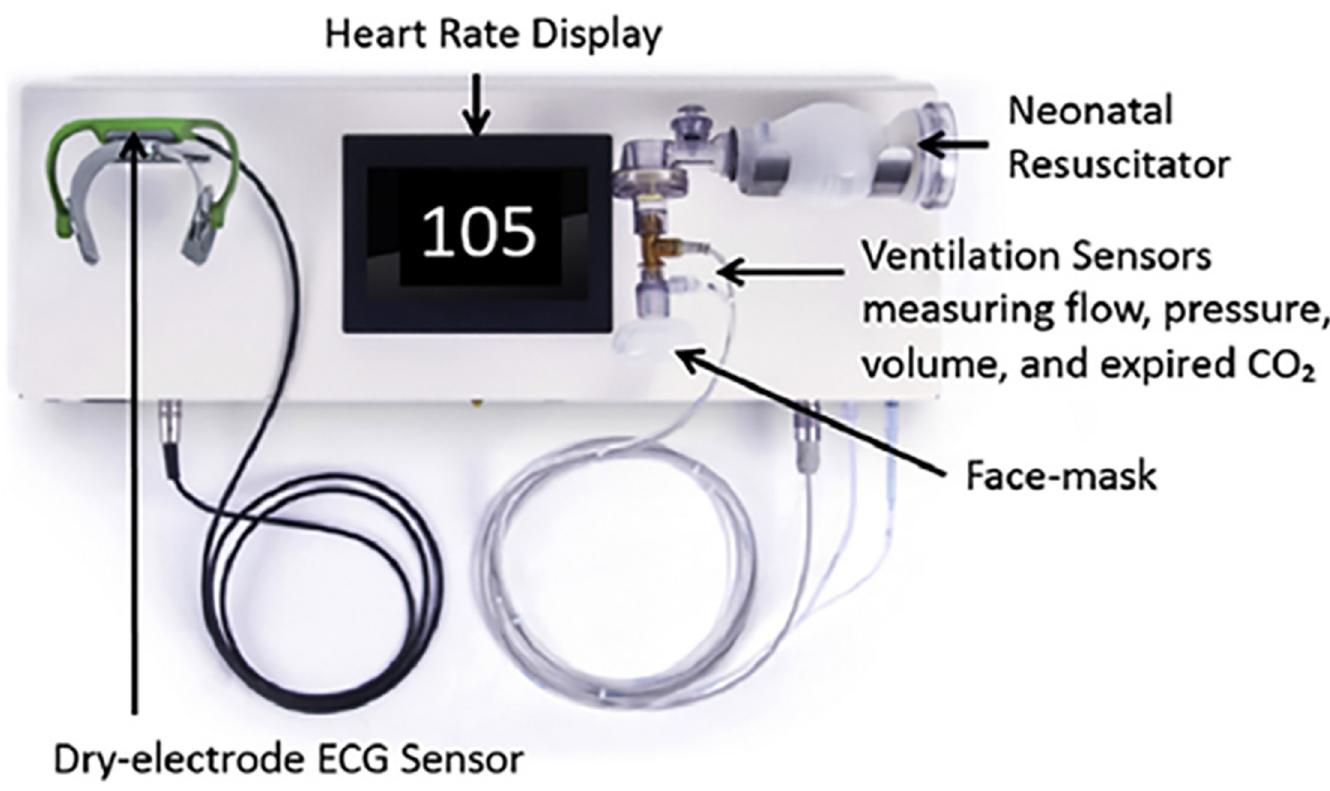
Fig 1. Neonatal resuscitation monitor and its components used for data collection at Haydom Hospital during 1.7.13 to 30.6.18.